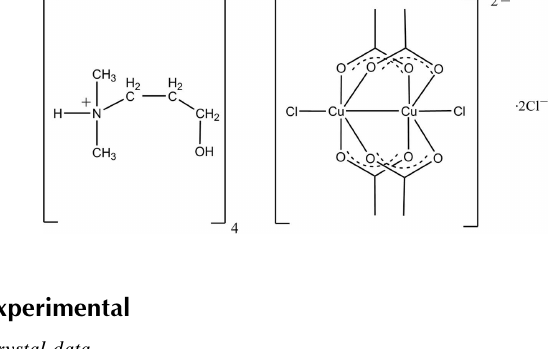
complexes, see: Shahid, Mazhar, Malik et al. (2008); Shahid et al. (2009); Zhang et al. (2004).